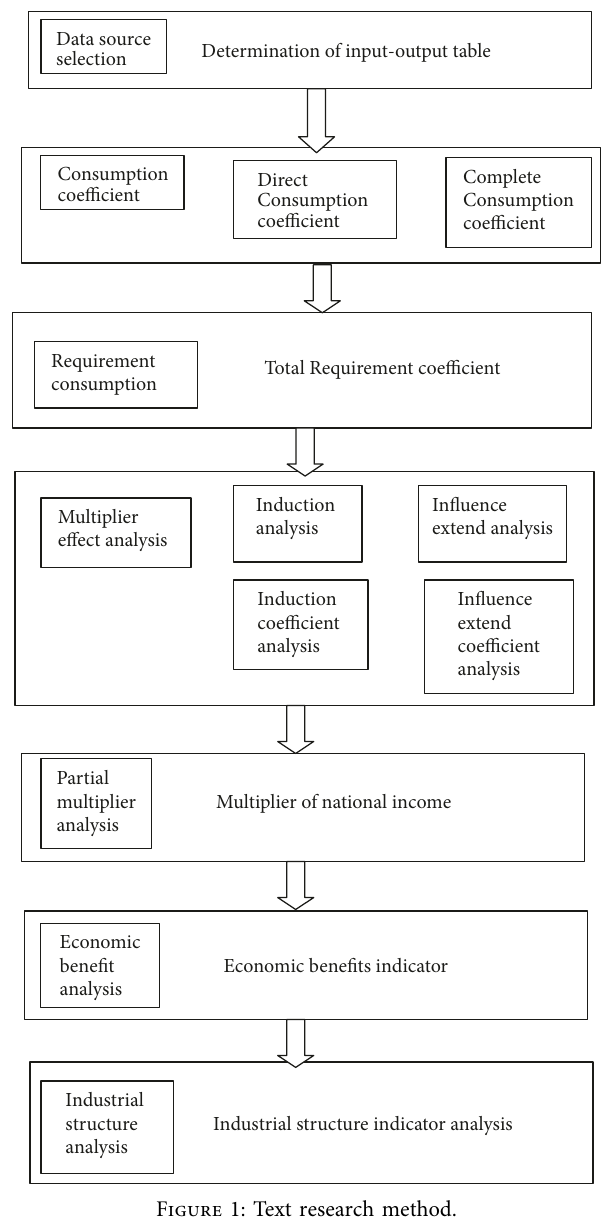
Figure 1: Text research